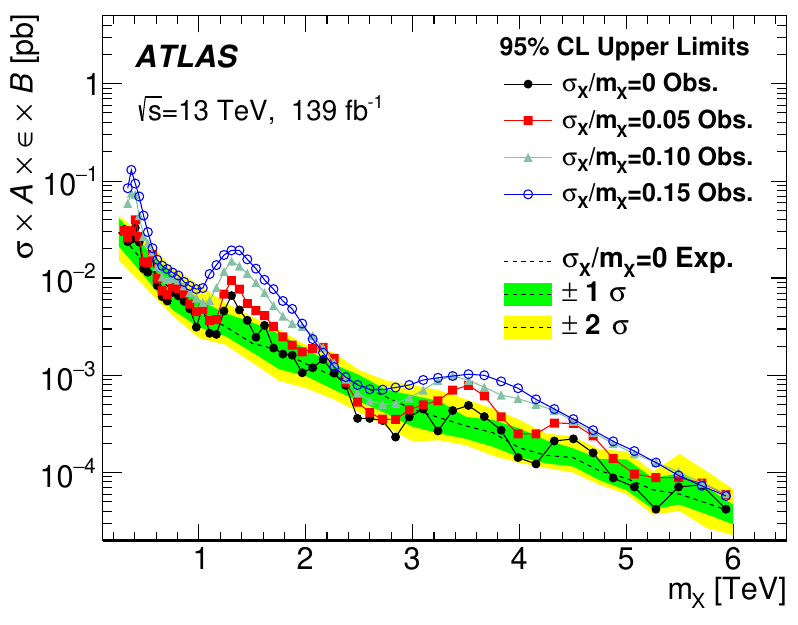
Figure 4. The 95% CL observed limits for a hypothetical particle X resulting in a contribution to the observed m jj distribution with a Gaussian shape and various widths (cid:27) X . The m jj distribution is obtained from the two leading jets in events with at least one isolated lepton with p ‘ > 60 GeV. T The limits, presented for the (cid:12)ne steps in masses that correspond to the bin sizes times two, are calculated assuming widths of the Gaussian signal corresponding to 0%, 5%, 10% and 15% of the signal mass. For the latter two cases, the points below m jj = 0 : 3 TeV are excluded since the signal would, in part, be at masses below the minimum value considered here. The limits are set on the cross-section times the acceptance A , the e(cid:14)ciency (cid:15) and branching ratio B . The expected limit and the corresponding 1 (cid:27) and 2 (cid:27) bands are shown for the (cid:27) X =m X =0 signals. (cid:6) (cid:6) statistical (cid:13)uctuation, and results mainly from the electron channel. The largest deviation from the background hypothesis for the muon channel shown in (cid:12)gure 3(b) is near 3.5 TeV, with the global p -value of